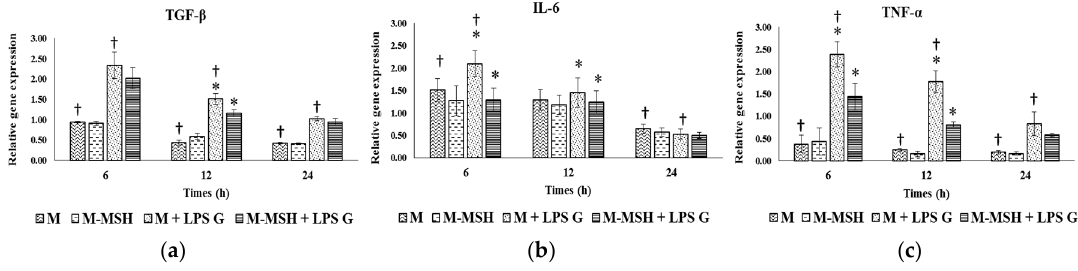
Figure 8. Gene expression of TGF ‐β ( a ); IL ‐ 6 ( b ); and TNF ‐α ( c ) in human oral epithelial cells with PCL membranes. Relative mRNA levels were analyzed by real ‐ time quantitative RT ‐ PCR for IL ‐ 6, TGF ‐β and TNF ‐α in EC after 6, 12 and 24 h on PCL cultures ( n = 4). Data are expressed as mean ± SD. †: di ff erence between non ‐ stimulated and stimulated cells, p < 0.05; *: difference between stimulated cells with or without PGA ‐α‐ MSH, p < 0.05.